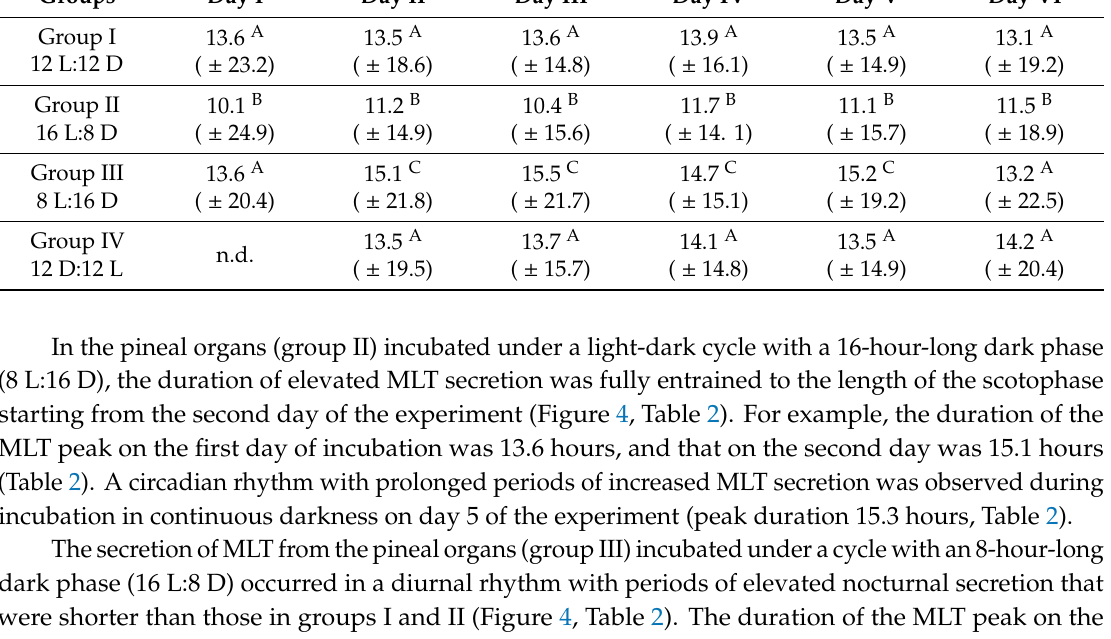
Figure 5. Experiment II. Secretion of MLT (mean) from turkey pineal organs incubated under a 12 L:12 D cycle (group I) and a reversed cycle 12 D:12 L (group III) during four consecutive days and then in continuous darkness.